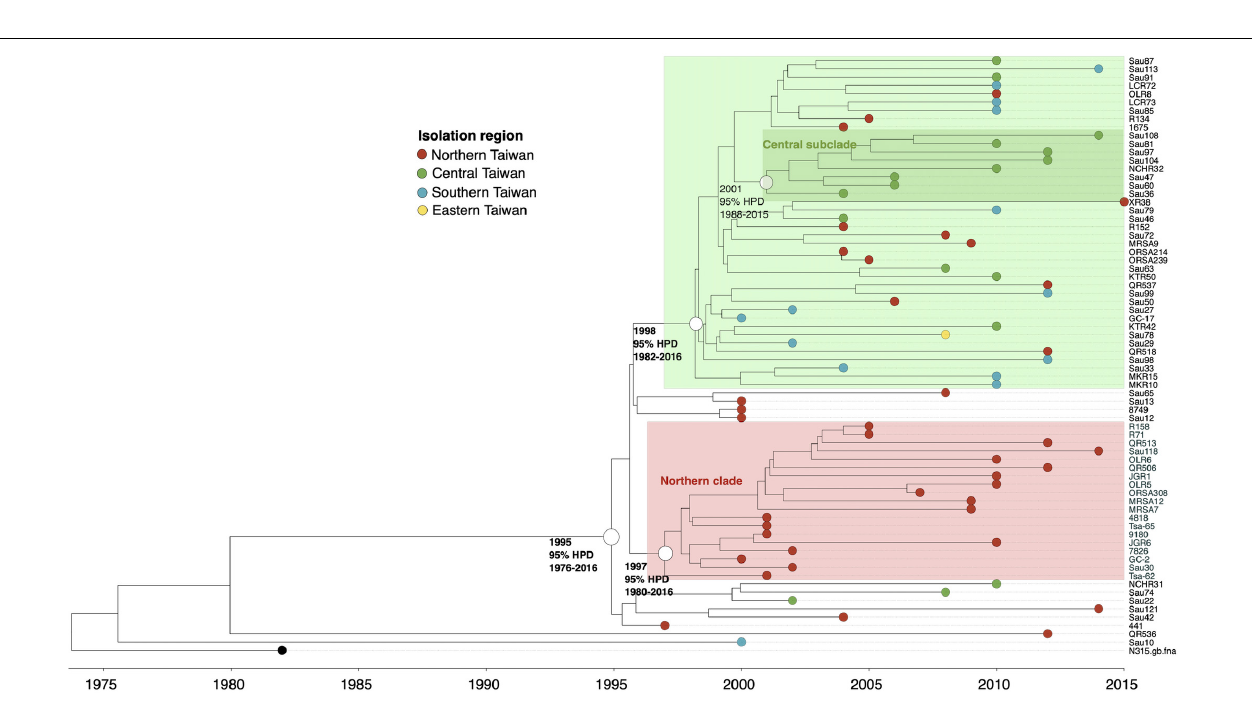
FIGURE 3 | Time-scaled phylogeny of 71 methicillin-resistant Staphylococcus aureus isolates of the ST5 lineage collected in Taiwan during 1996 and 2016. The hollow circles indicate the most recent common ancestors of isolates of the indicated clade and its estimated year of appearance. HPD, highest posterior density; SLV, single-locus